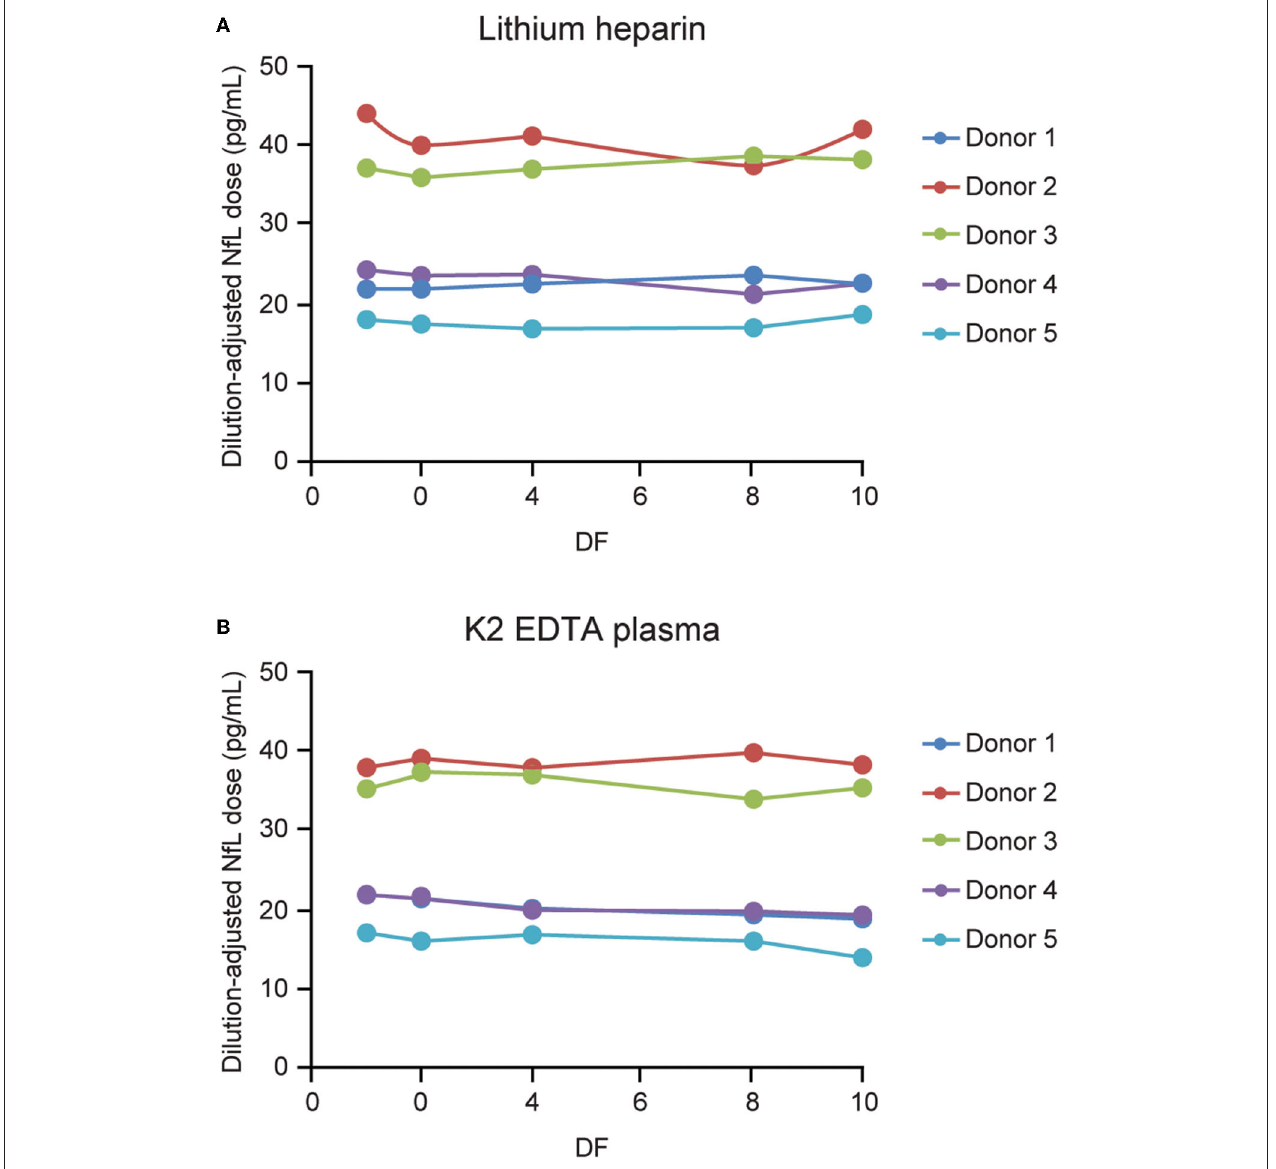
FIGURE 7 | Parallelism for plasma tube types. Five matched lithium heparin (A) and K2 EDTA (B) samples with endogenous NfL levels of up to 45 pg/mL were tested, and diluted 2-, 4-, 8-, and 10-fold using NfL sample diluent. DF, dilution factor; NfL, neurofilament light